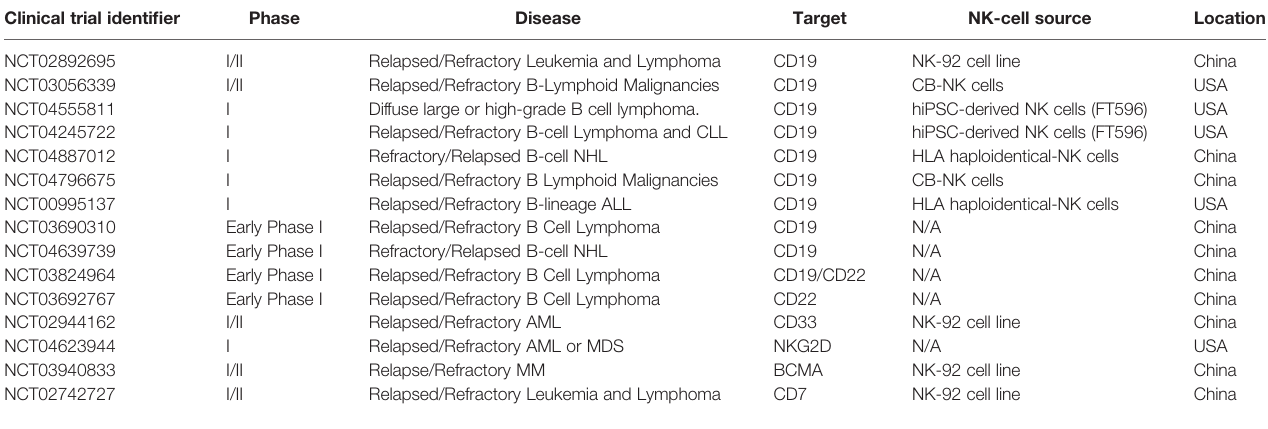
TABLE 1 | CAR-NK-cell therapy for hematological malignacies registered in clinicaltrials.gov. Clinical trial identi fi